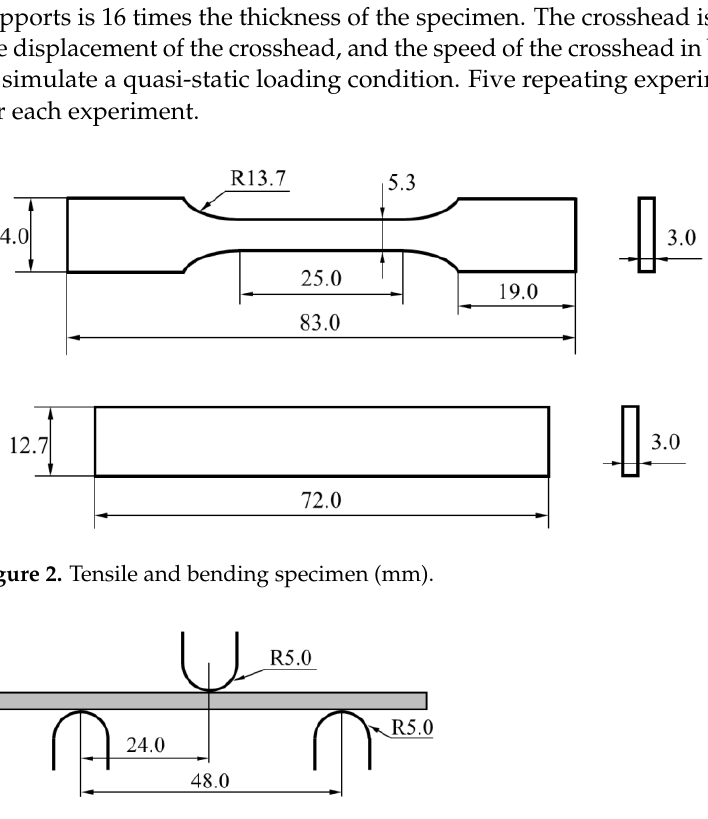
Figure 1. Hot compression method for PEEK. ( a ) Hot compression device schematic. ( b ) Schematic diagram of parameter setting for PEEK sheet preparation process.